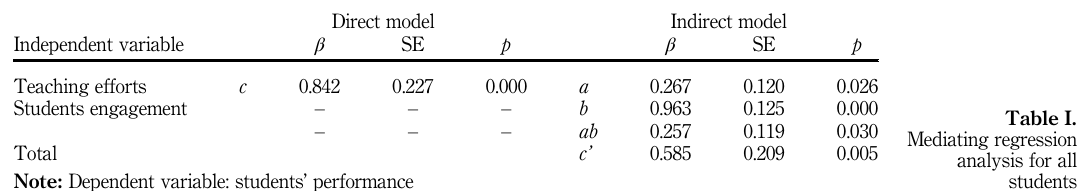
analysis for all